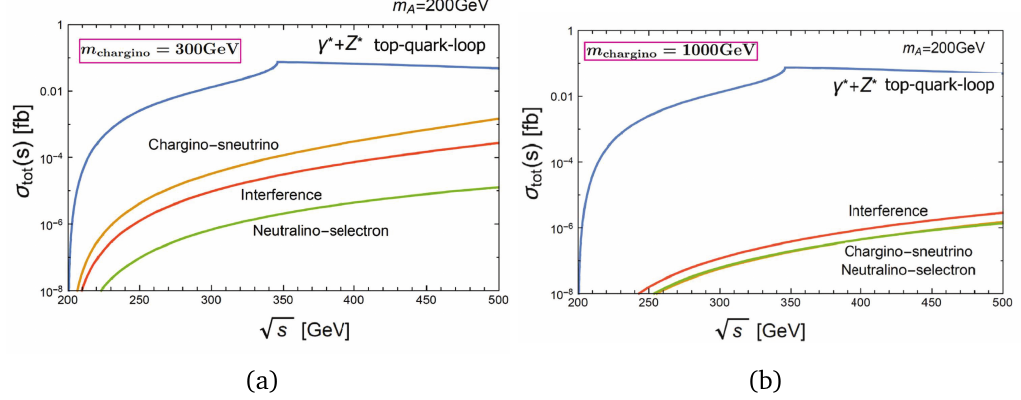
Figure 6: Top-quark vs. box-diagrams contributions:(a) mass of chargino 300 GeV and (b)mass of chargino 1000